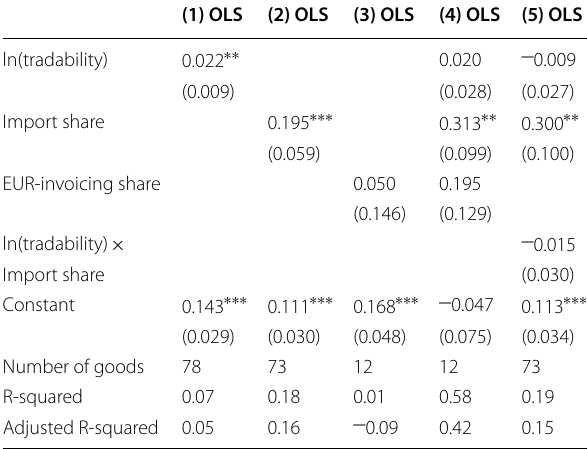
Table 3 Imports and pass-through heterogeneity (1) OLS (2) OLS (3) OLS (4) OLS (5)